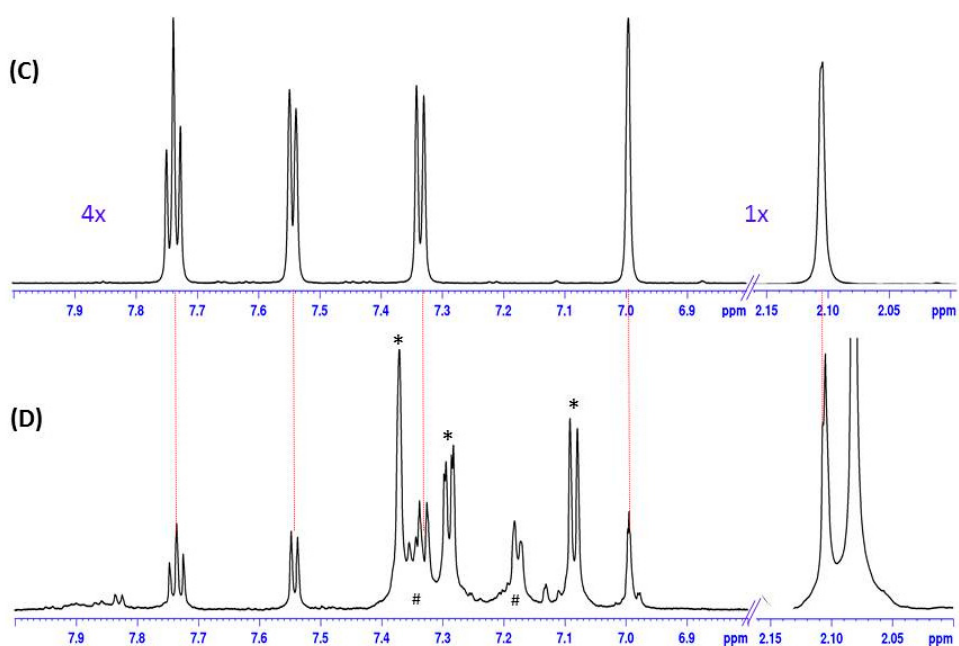
Figure 4. 1 H-NMR spectra in DMSO- d 6 . ( A ) Plumbagin (see insert) extracted from Nepenthes x ventrata leaves and ( B ) a plumbagin reference. ( C ) Details of 1 H NMR spectra of a plumbagin reference and ( D ) the volatile exudate emitted by N. x ventrata pitcher material. Asterisks (*) indicate the presence of 4-tert-butylcatechol, a polymerization inhibitor probably extracted from the plastic material, and hashes (#) account for an unidentified impurity. The intensity of the aromatic range in ( C ) was increased as indicated by the